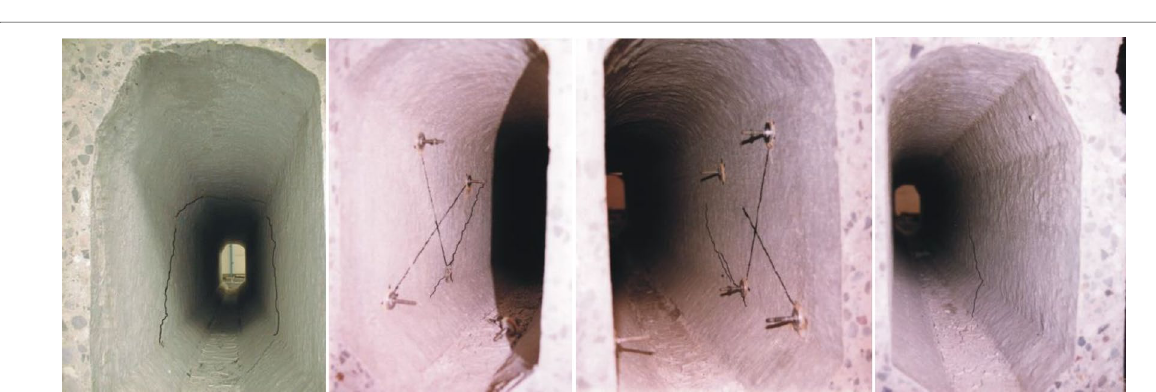
Fig. 9 Shear tests: experimental crack pattern registered inside the hollows of slab H50-s2, in correspondence of the ultimate applied